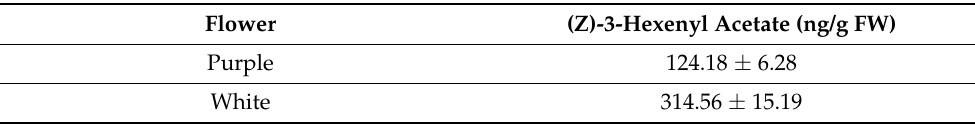
Table 3. Semi-quantitative determination of (Z)-3-Hexenyl acetate in white and purple flowers of T. violacea (ng/g fresh